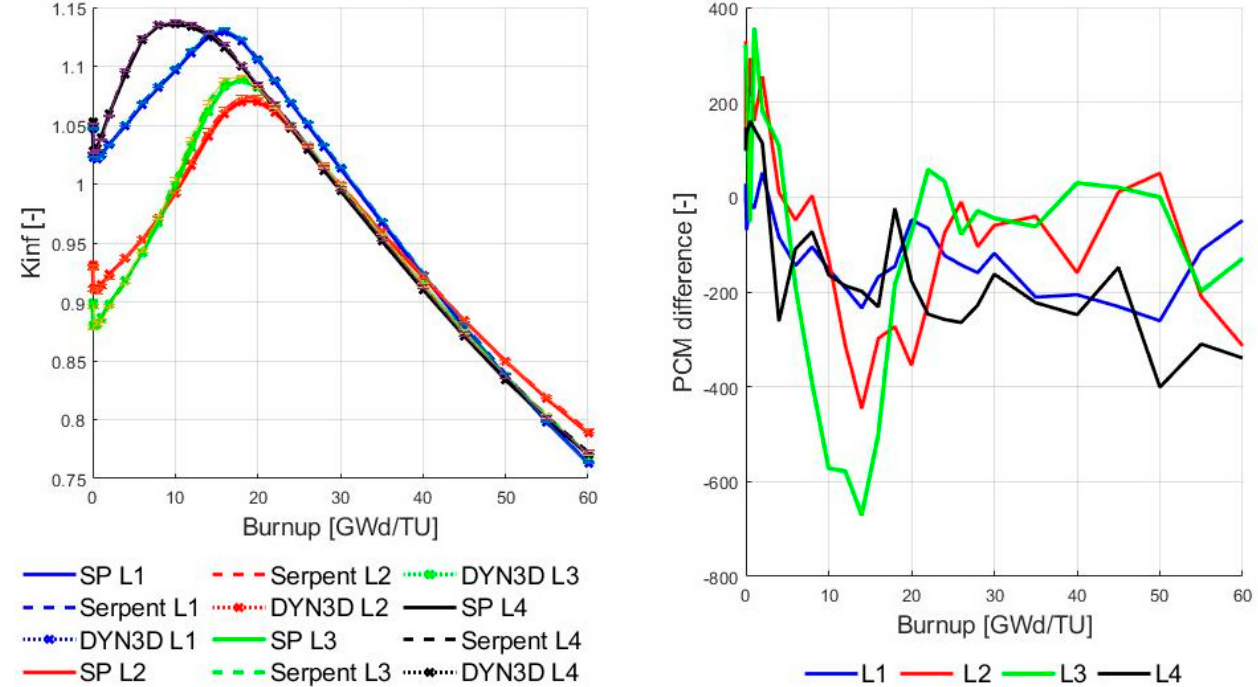
Figure 7. k inf over Burnup of assembly two up until 60 GWd/TU comparing SP, DYN3D and Serpent. The PCM variation at each burnup stage (SP ‐ Serpent).